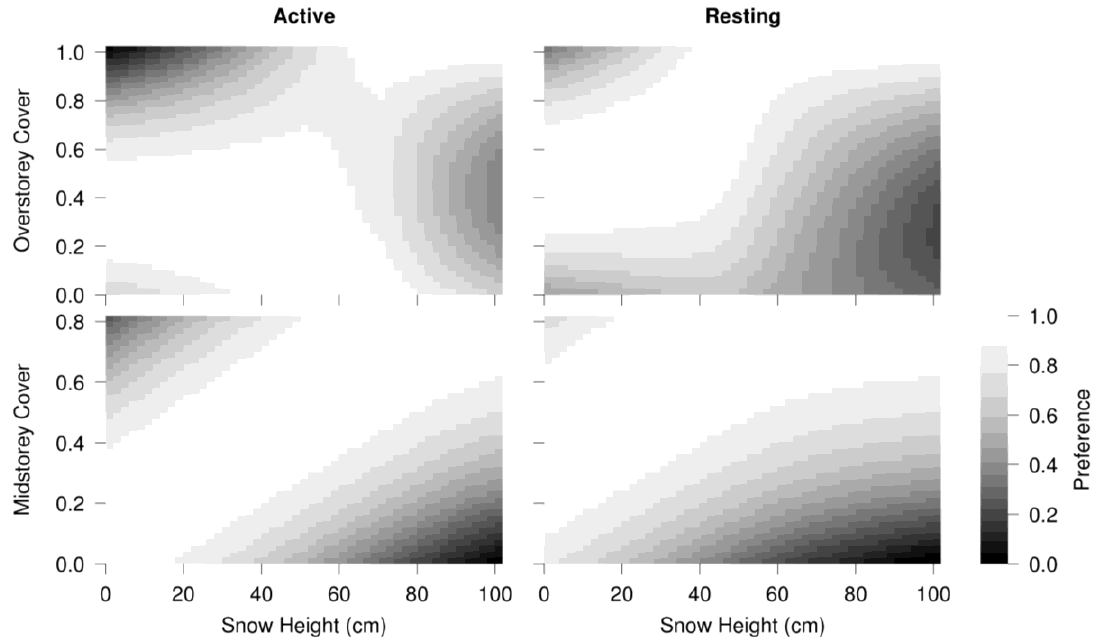
Figure 4. Predicted relative preference values for overstory cover (10 m–60 m) and midstory cover (2 m–10 m) as a function of snow height for active and resting roe deer; values represent expected values estimated by mixed conditional logistic regression; not-displayed variables were set to their data set mean. Preference values were scaled between 0 and 1 to keep results between different temperatures